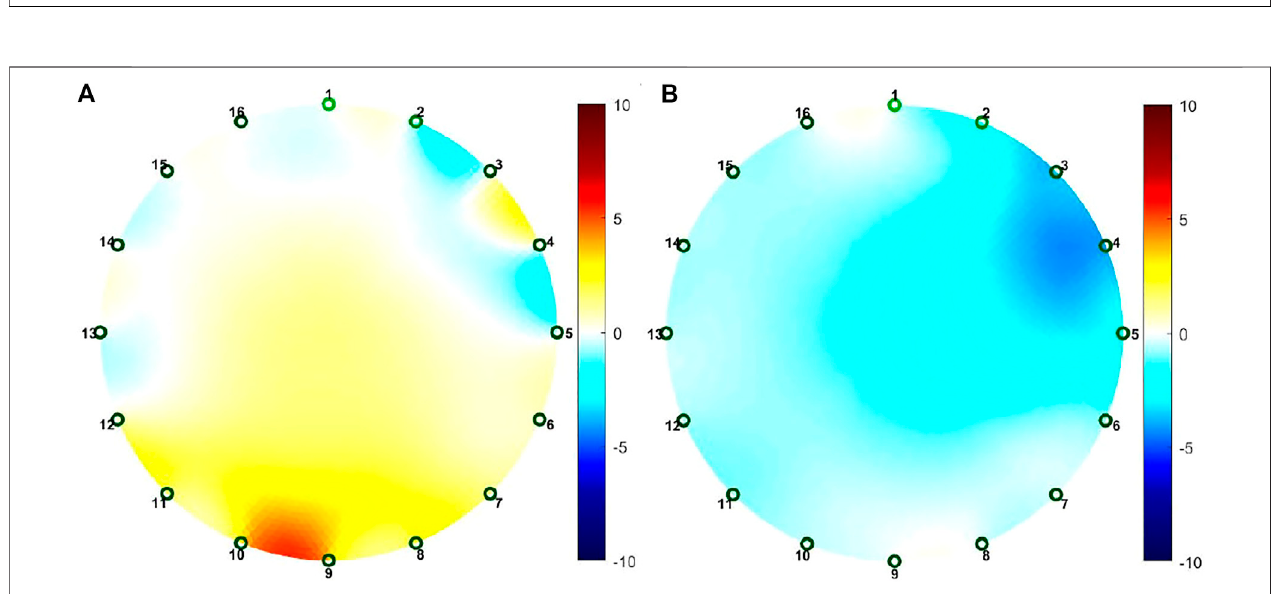
FIGURE 12 | (A) Error image (ZX-ZM) as a graphical estimation of the error introduced by the multiplexers. (B) Error Image AX-(ZX-ZM)-AM obtained by element- by-element subtraction to correct the multiplexed image.